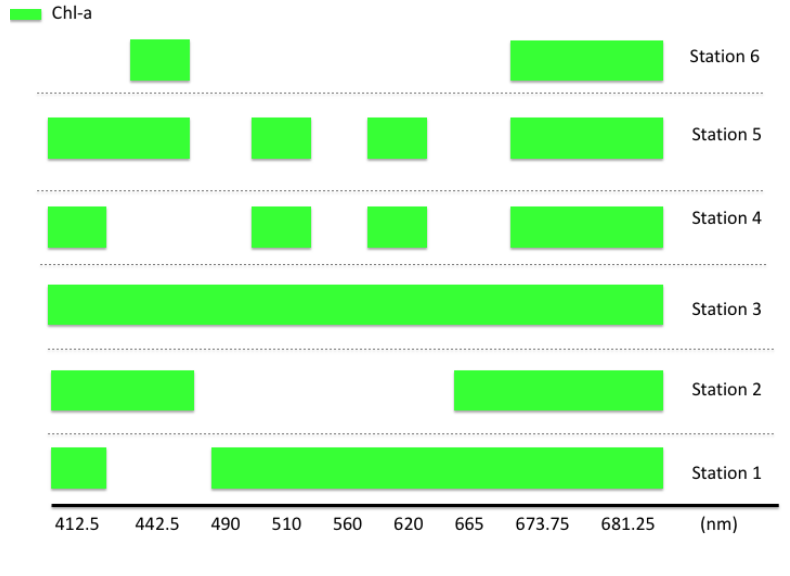
Figure 7. The most important spectral bands of Chl-a for each